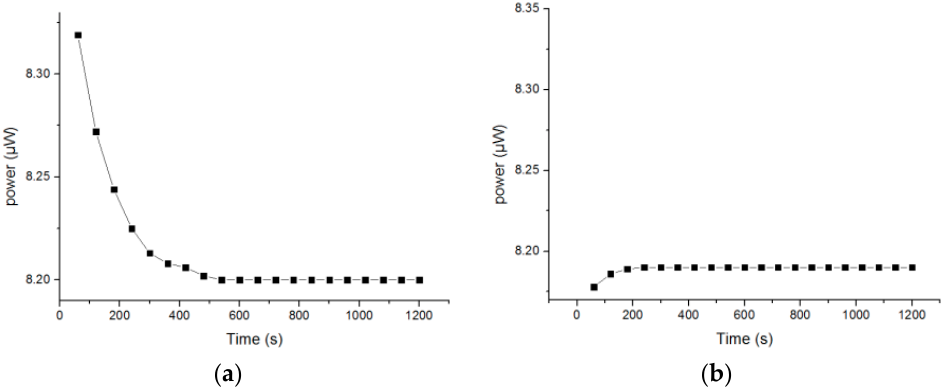
Figure 8. ( a ) First measurement; ( b ) second measurement.